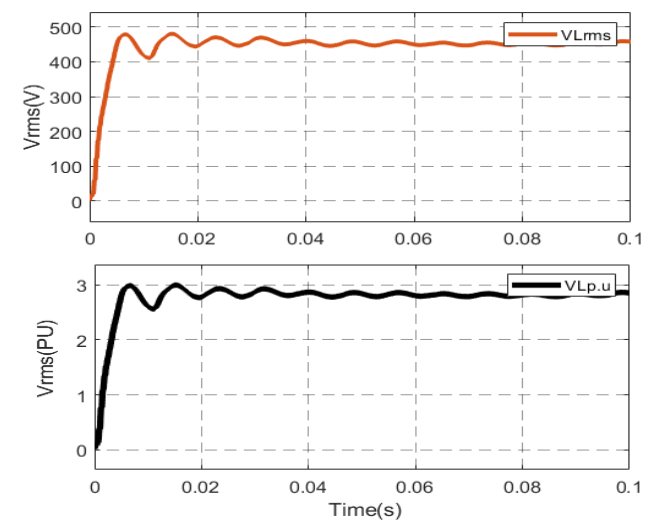
Figure 10. Message signal: ( top ) original signal, ( bottom ) scaled down